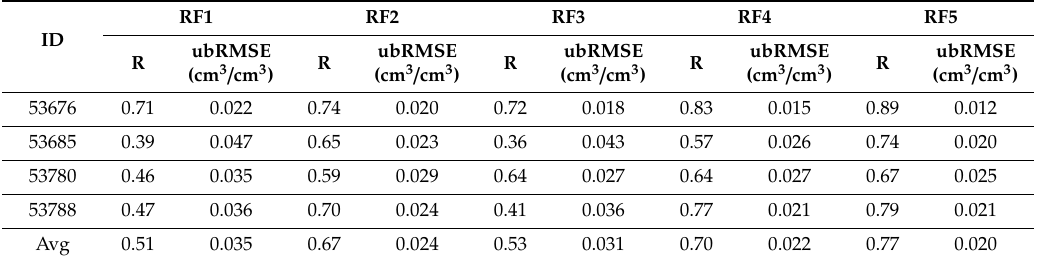
Table 3. Results comparison summary for the 1 km downscaled SM based on RF1–RF5 vs. in situ SM. The number of samples at stations 53676, 53685, 53780, and 53788 is 22, 21, 20 and 20, respectively. Avg is short for average.